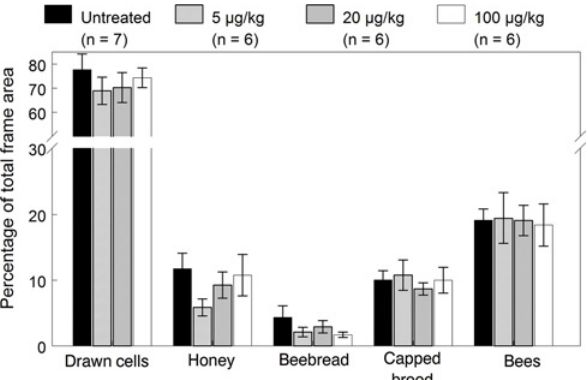
Fig 7. Colony performance endpoints (mean ± SE) of the 2010 colonies recorded on October 7 prior to overwintering (about seven weeks after